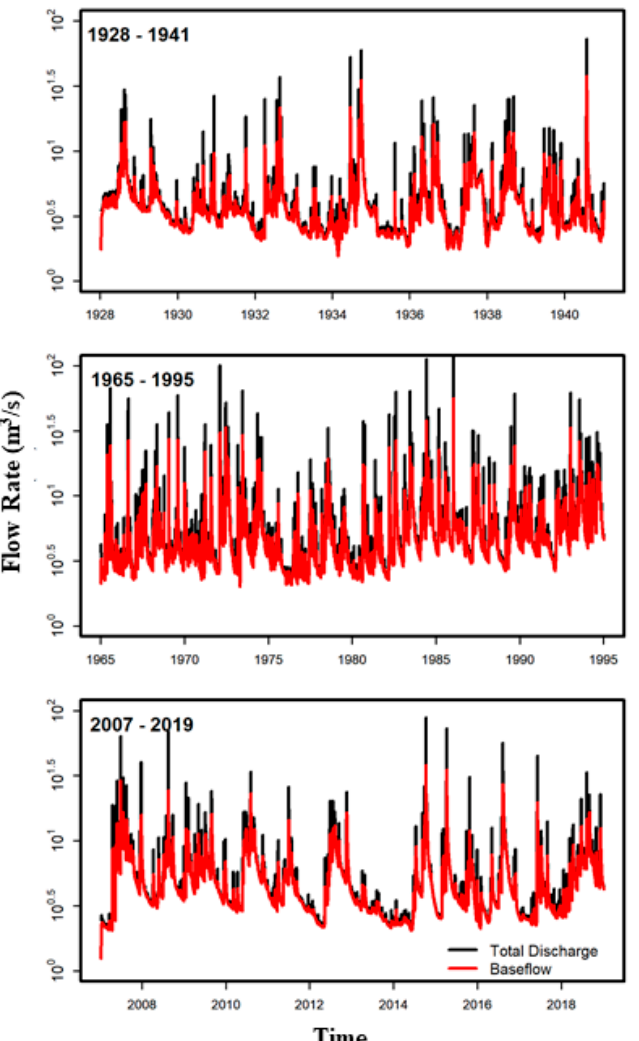
Figure 3. Separation of flow components for Bennett Spring over different time intervals using WHAT.